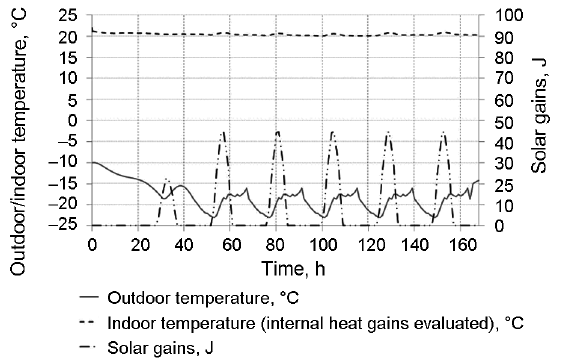
Fig. 6. Dependence of indoor temperature on the peak power of heating system at varying outdoor temperature. Period: theoreti- cally framed period, Fig. 4; power: 1.52